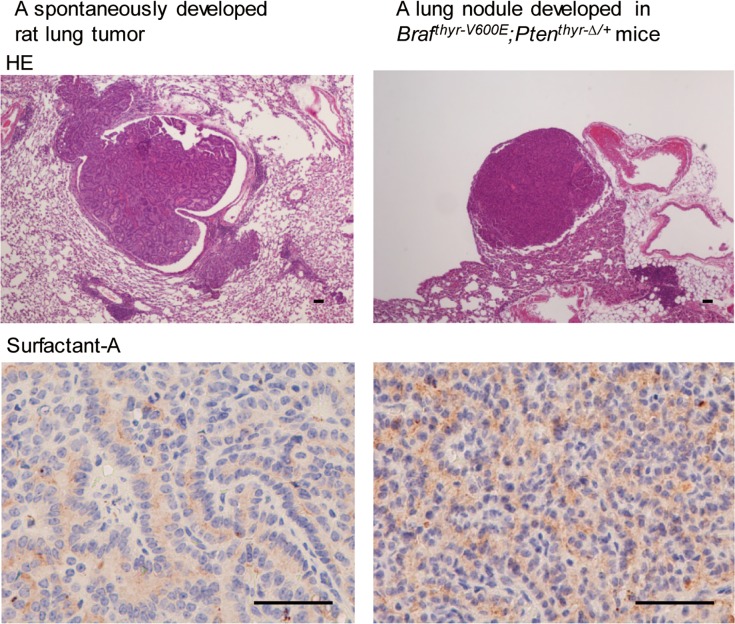
H & E and surfactant protein-A staining in a spontaneously developed rat lung tumor [22] (as a positive control) and in a lung nodule developed in Brafthyr-V600E;Ptenthyr-Δ/+ mouse.Scale bars, 50 μm.